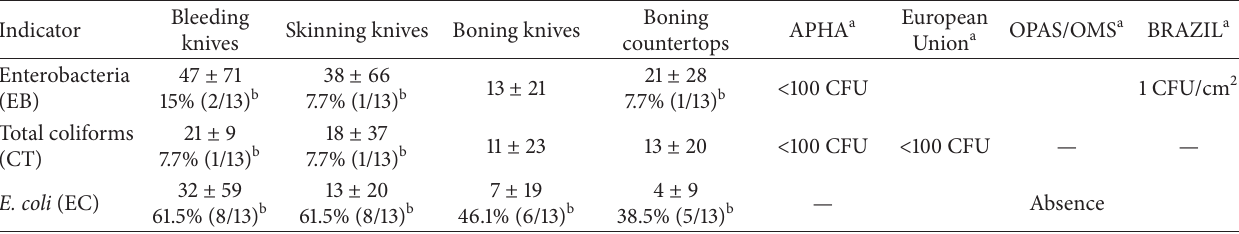
Table 1: Enterobacteria, coliform, and Escherichia coli count averages in utensils and equipment used in the slaughter of cattle and in meat processing in refrigerator slaughterhouses in the state of Mato Grosso, Brazil.